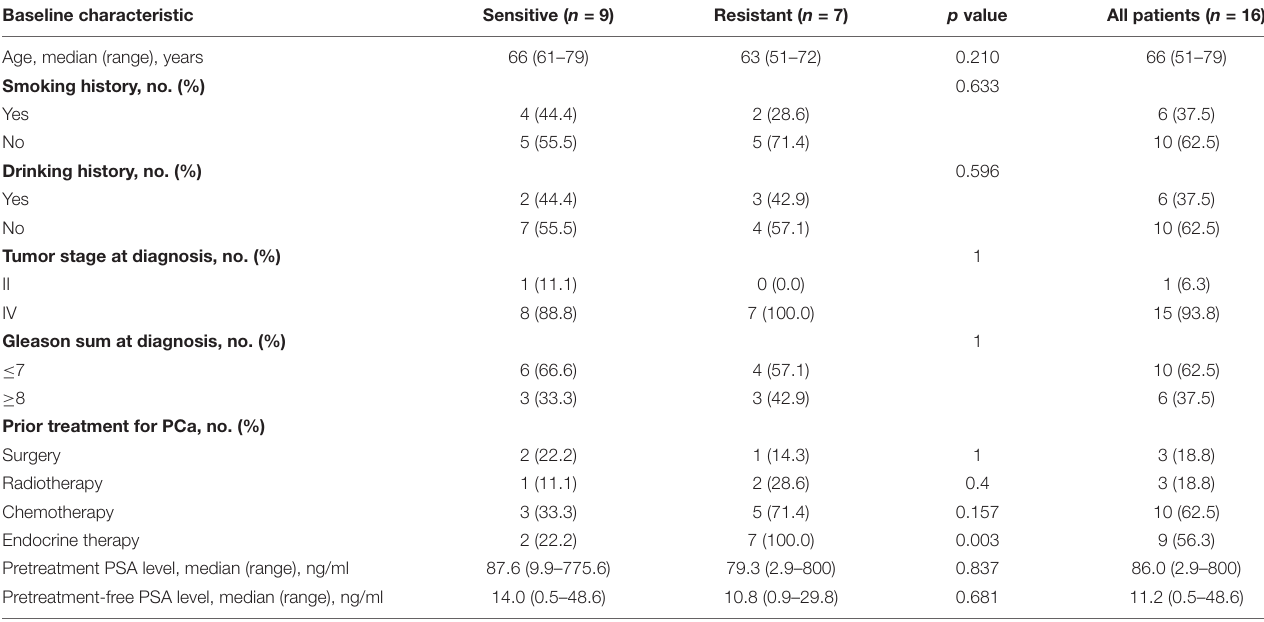
TABLE 1 | Comparison of baseline characteristics between dicycloplatin-sensitive and dicycloplatin-resistant